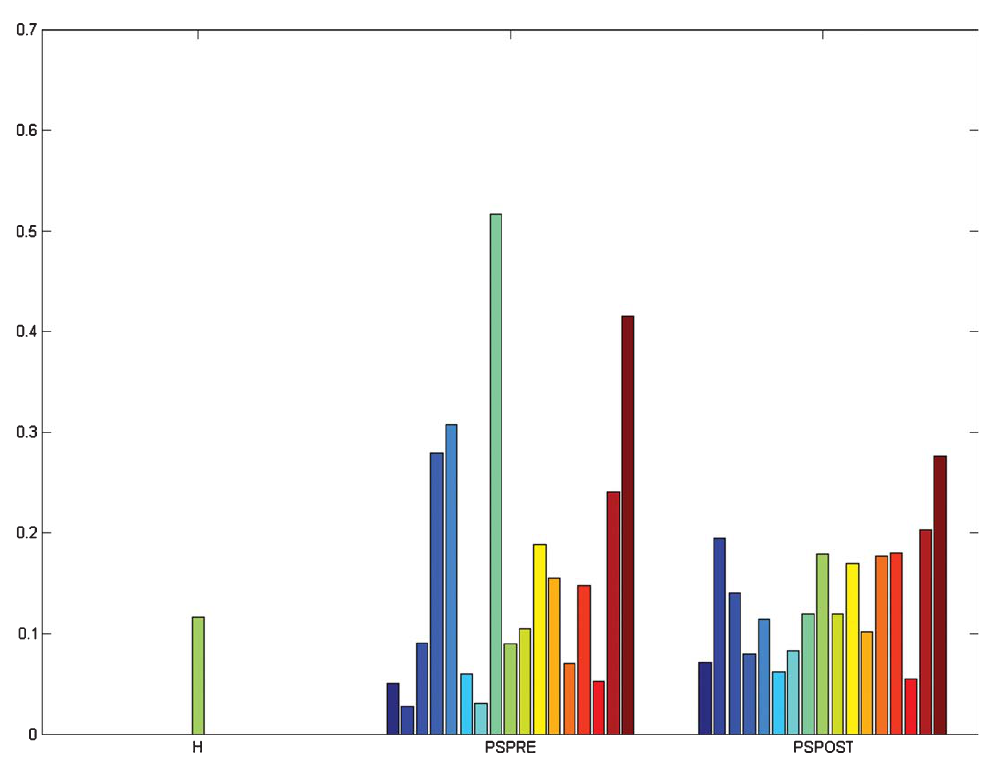
Fig. 9. Subjects’s values of parameter Mean ( (cid:1) F ) for direction S b , in P H , P PSPRE and P PSPOST (Y-axis units: